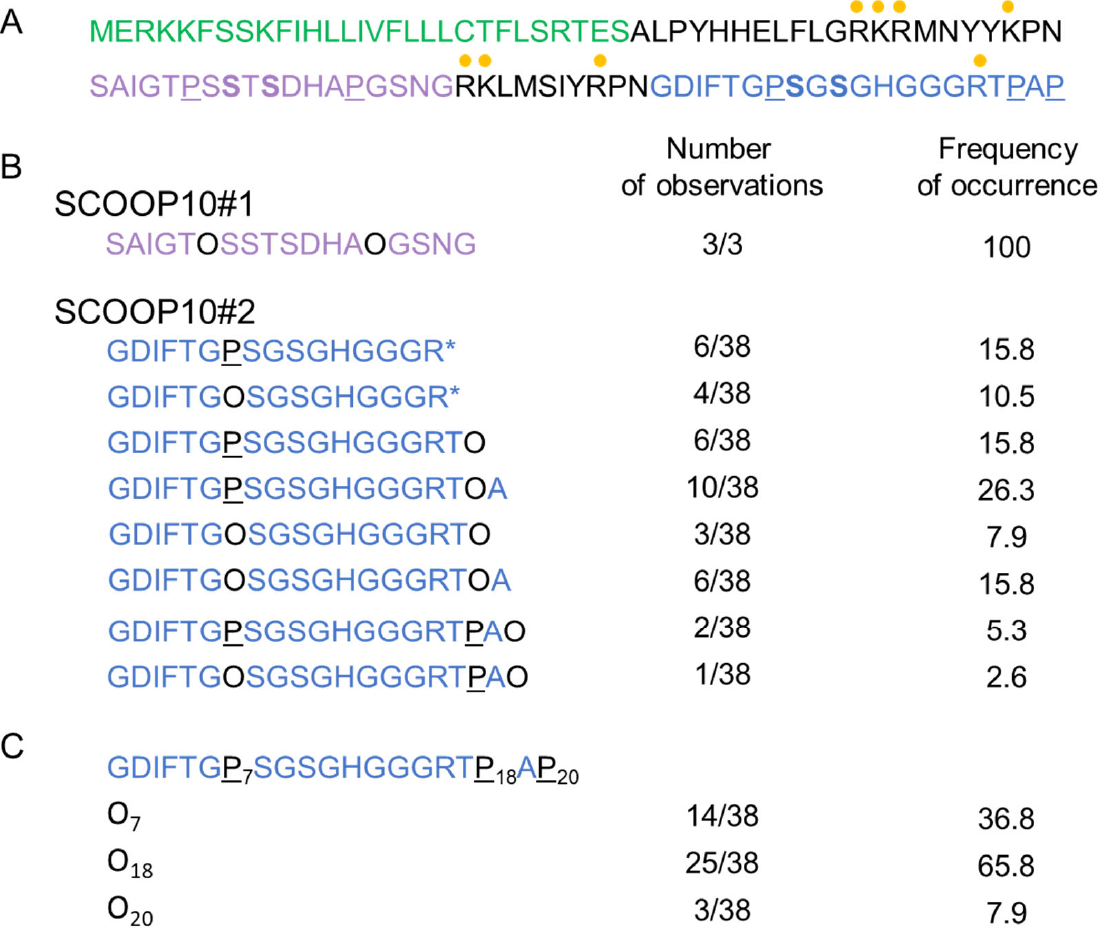
Figure 1. Identification of two SCOOP10 peptides by MS. ( A ) Sequence of the prepropeptide PROSCOOP10. The predicted signal peptide is in green, the mature SCOOP10#1 in purple and the mature SCOOP10#2 in blue. The tryptic cut sites (arginine (R) and lysine (K)) are indicated with yellow dots. The proline residues that were found to be hydroxylated are in black and underlined (P). The conserved serine residues are in bold. ( B ) Description of the different peptides covering the SCOOP10#1 and SCOOP10#2 amino acid sequences. The positions of P hydroxylation are indicated with O, which stands for hydroxyproline. Stars indicate that the peptide was identified after tryptic digestion. The frequency of observations of each peptide is indicated, as well as the percentage of occurrences. ( C ) A focus on SCOOP10#2 to show the number of observations and the frequency of hydroxylation events at each P position.